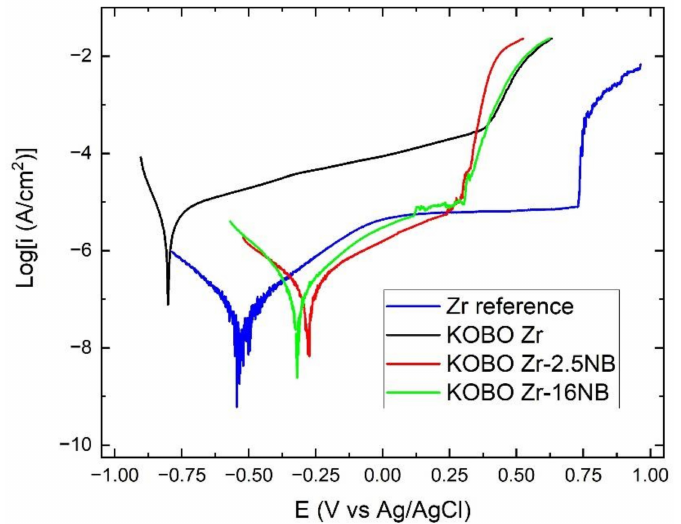
Figure 11. Potentiodynamic polarization curves for the corrosion test of KOBO-extruded Zr-xNb alloys in 3.5% NaCl solution.